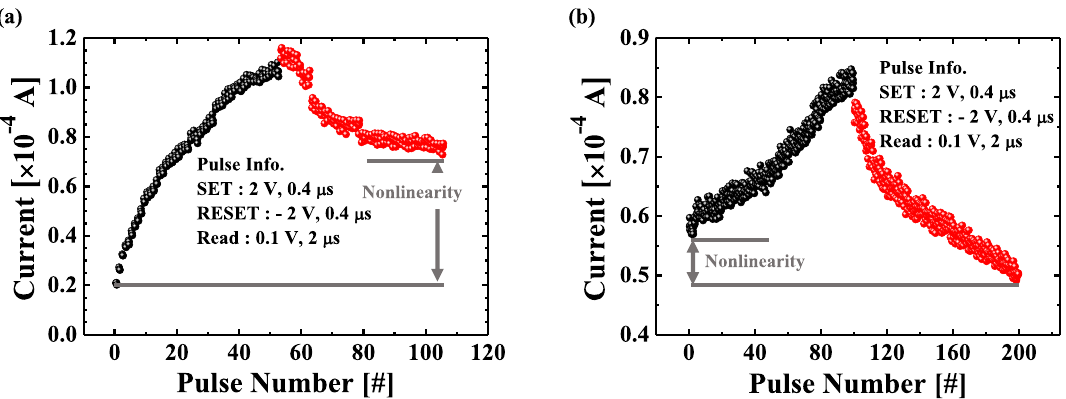
Figure 7. Long-term potentiation (LTP) and depression (LTD) characteristics of ( a ) single IGZO and ( b ) bi-layer IGZO/ZnO memristors. The applied positive/negative pulses were 50 for a single IGZO and 100 for bi-layer IGZO/ZnO memristors, respectively, and the current was read after each stimulation pulse was applied. The linearity and symmetricity of the LTP and LTD characteristics for bi-layer IGZO/ZnO memristor show more improved linearity than that for a single IGZO memristor.